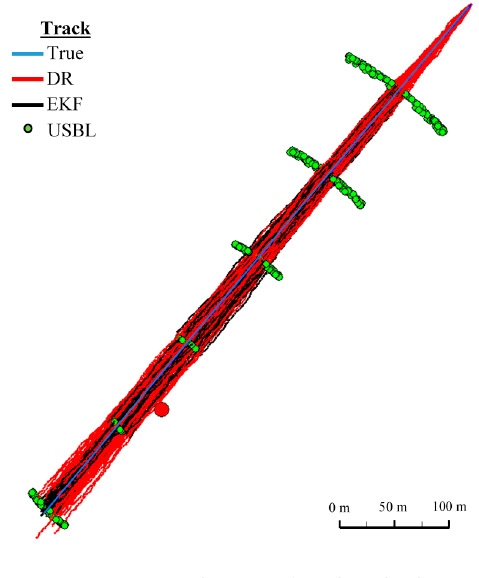
Figure 30. Determining the route (one hundred passages).